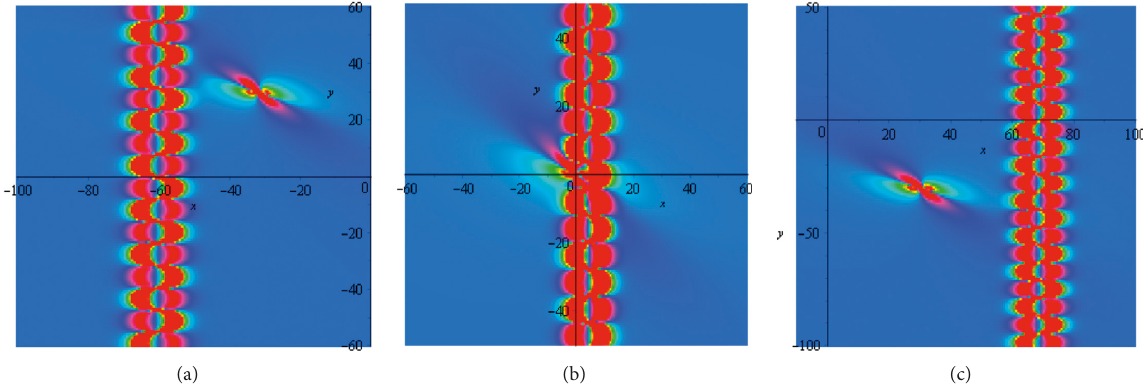
Figure 19: Plots of equation (81) by utilizing ϕ (c) f 3.